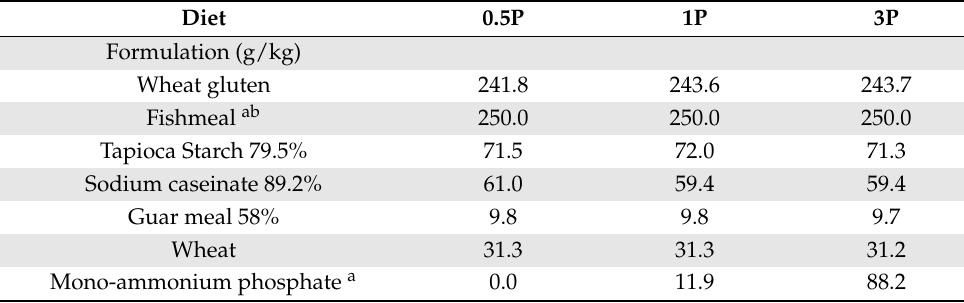
Figure 1. Experimental set-up and analysis. Animals were acclimatized for three weeks prior to phosphorus (P) feeding. Atlantic salmon were subsequently fed different levels of total phosphorus (P) 0.5P (6.3 g/kg), 1P (9.0 g/kg), and 3P (26.8 g/kg) and reared in conditions with no CO 2 injected (5 mg/L) (5CO 2 ) or with injected CO 2 (20 mg/L) (20 CO 2 ) for 13 weeks (weeks 3–16) in seawater. Each treatment was made in duplicates. Analyses, types, and number of samples taken at specified time-points are indicated. Table 1. Formulation and analyzed composition of experimental diets.